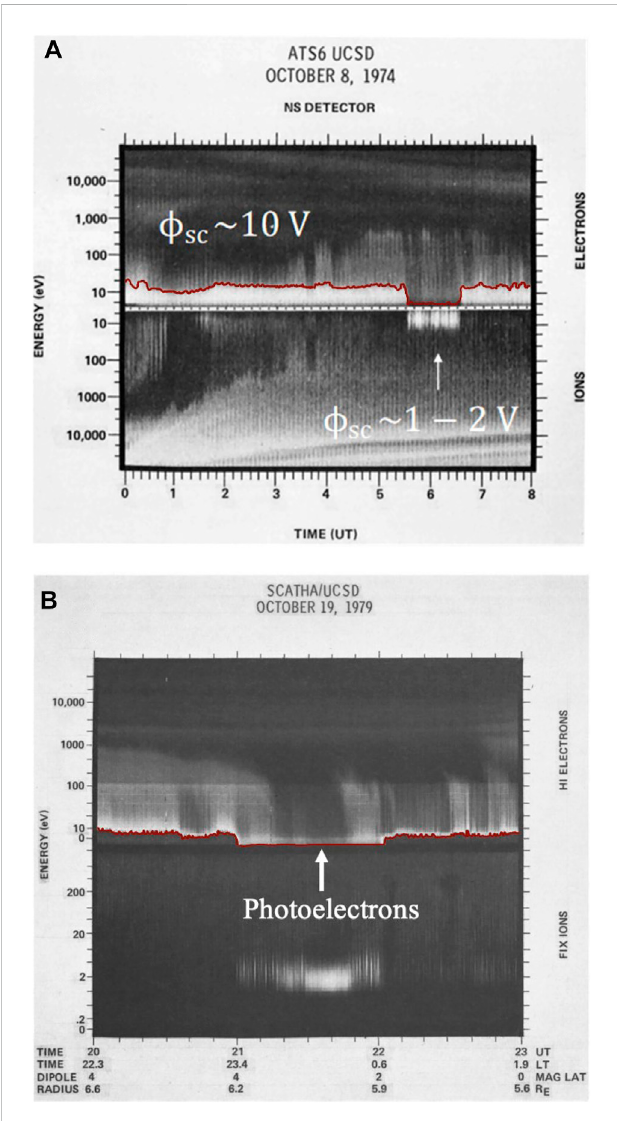
FIGURE 2 From (Olsen 1982) (A) ATS six measurements in the plasma sheet in eclipse, (B) SCATHA Hi electron data where photoelectron fl uxes are